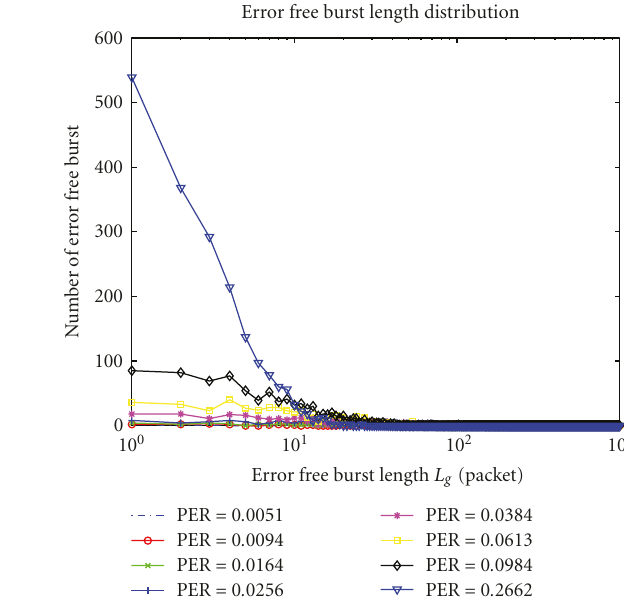
Figure 6: Error bursts distribution. Figure 7: Error-free burst length